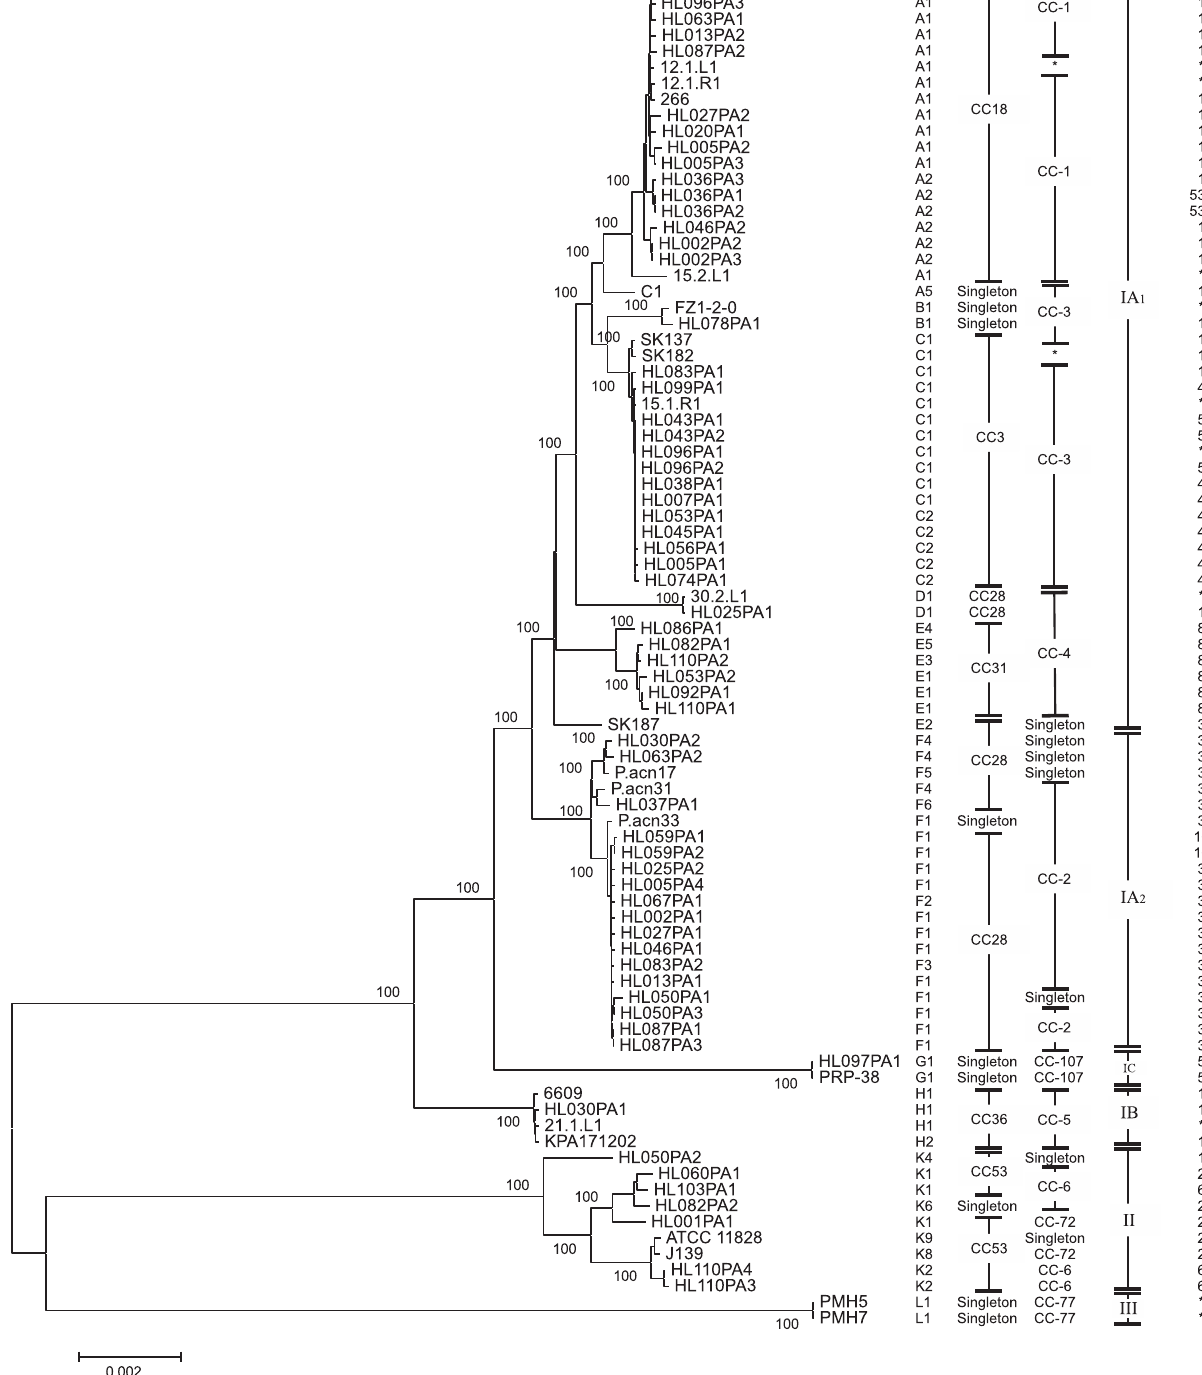
Figure 1. The SLST scheme discriminates the phylogenetic clusters of P.acnes . Minimum Evolution phylogenetic tree based on 86 complete and draft P. acnes genomes, generated in MEGA v. 5.22 and based on a 1,964,522-bp concatemer of core sequences. Only bootstrap values of 100% are shown. The leftmost column depicts the identified SLST type. Type designations according to MLST9 and MLST8 schemes and ribotyping are also given, in addition to the traditional type assignments based on recA and tly sequence analysis. * indicates unknown types.